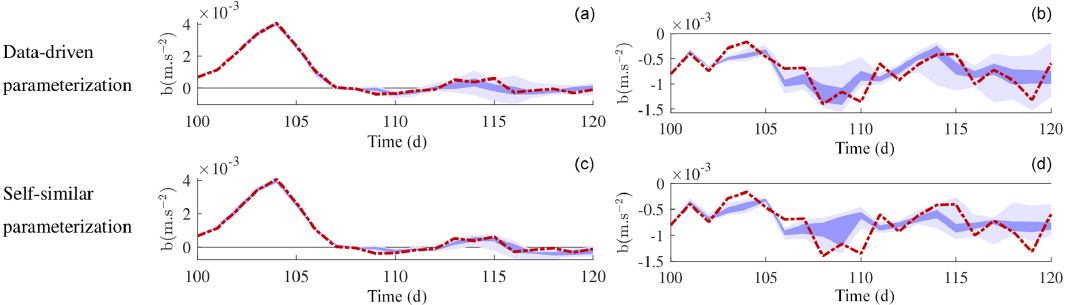
Figure 14. Confidence interval at 95% (light purple) and at 50% (dark purple) along time, computed from the low-resolution stochastic SQG 20-member ensemble with the data-driven (a, b) and with the self-similar (c, d) parameterization, at the points (500, 250km) (a, c) and (250, 500km) (b, d) . The high-resolution reference is superimposed in